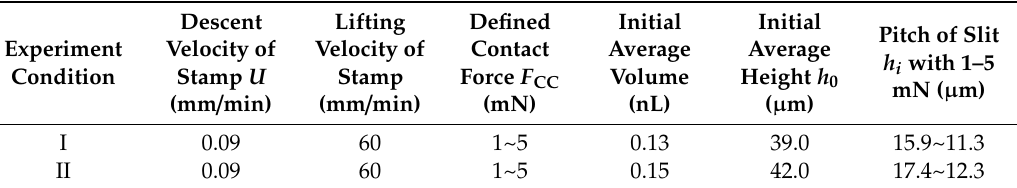
Table 2. Dispensing parameters.